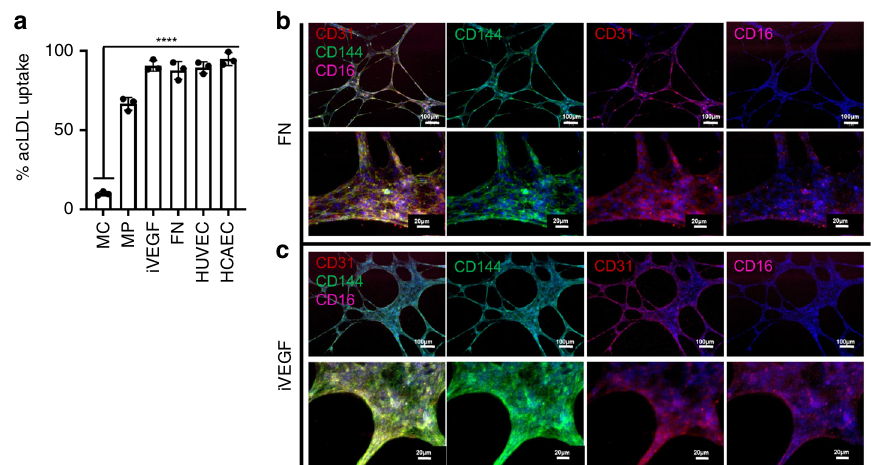
Fig. 7 MC-derived EC develop endothelial function. a MCEC differentiated on FN or iVEGF uptake acetylated LDL. MC on day 0 are unable to uptake LDL compared to traditionally activated, LPS stimulated M Φ , MCEC on FN or VEGF or HUVEC or HCAEC. (**** p < 0.0001) statistical signi fi cance using one- way ANOVA and Sidak ’ s test (DF = 12, F = 205.1); n = 3 independent biological replicates; error bars indicate ±SD of the mean. MCEC differentiated on FN ( b ) or VEGF ( c ) formed tubular networks when cultured on Matrigel. Representative immunostaining for the monocyte markers CD16 (pink), endothelial marker CD144 (green), and CD31 (red) over n = 5 independent biological